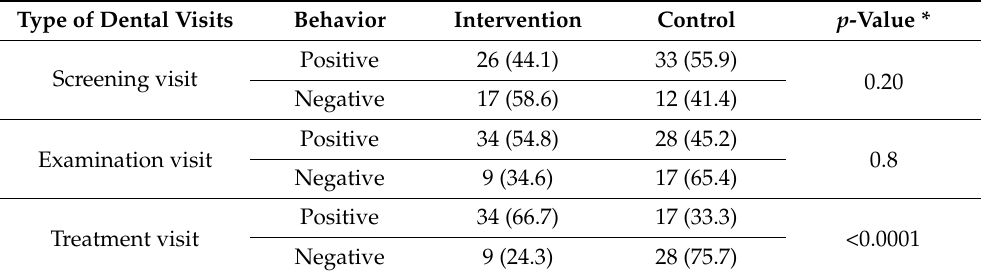
Table 5. Comparison of Venham scores between groups at different visits.